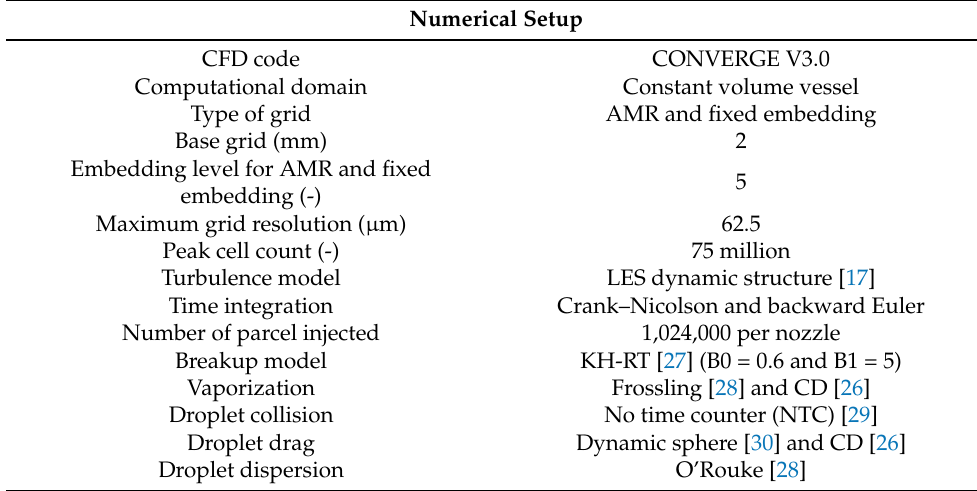
Table 3. Numerical setup and models